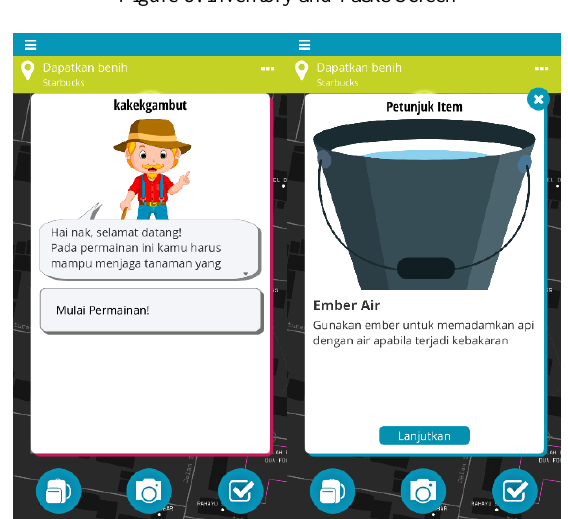
Figure 9. Character dialogue and clue screen